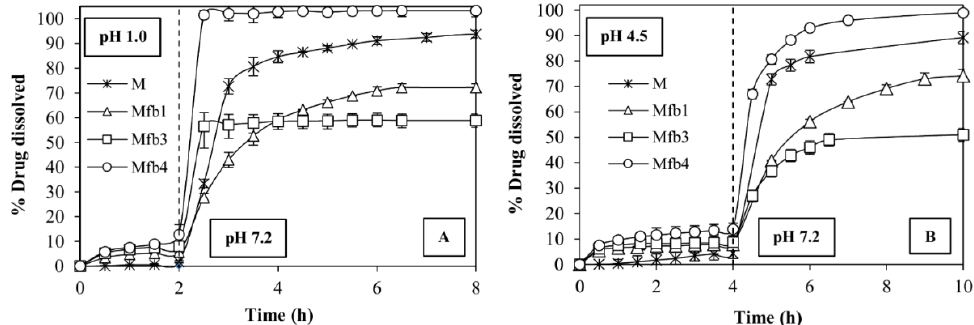
Figure 5. Dissolution profiles of M, and drug-loaded fibers obtained by HPMC-AS 716 (Mfb1), HPMC-AS912 (Mfb3), and by combining HPMC-AS912 and HPMC K100LV (Mfb4) in two different pH change methods: pH 1.0 for 2 h and then pH 7.2 ( A ) and pH 4.5 for 4 h and then pH 7.2 ( B ). All samples contain a dose of 7.5 mg of M.